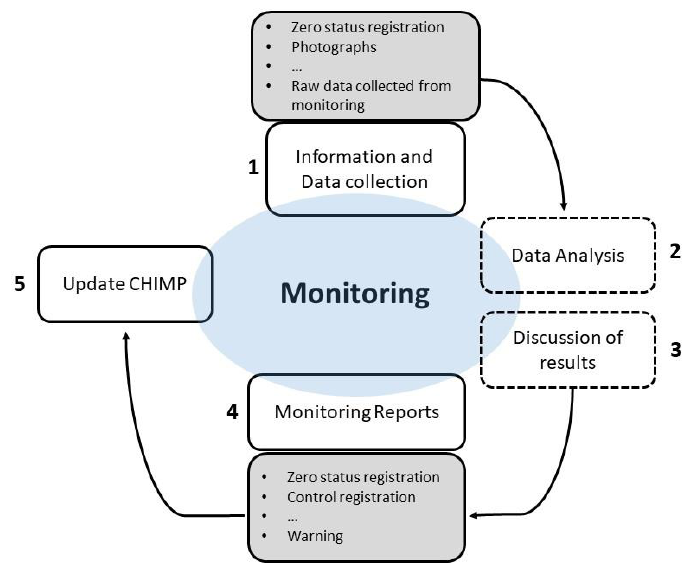
Figure 8. Incorporation of a long-term monitoring program in a Cultural Heritage Integrated Management Plan (CHIMP). Transparent boxes with solid border: information, data, and report publicly available in the official database of the Directorate for Cultural Heritage in Norway named “Askeladden.” Boxes with dashed border: information available internally in the main project group. Gray boxes: examples of information, data, and reports within the monitoring program.